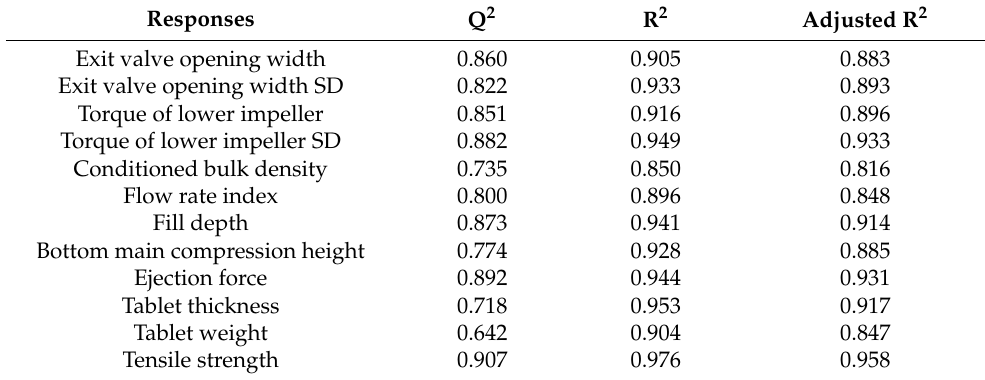
Table 11. Overview of the models obtained in this study.